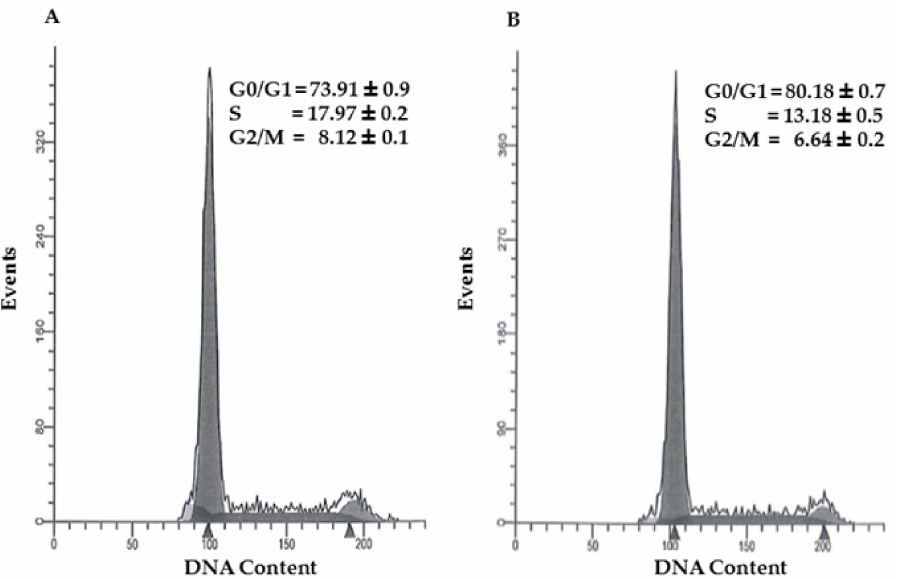
Figure 5. E ff ect of ( R ) - 1 on cell cycle. The cells were incubated for 48 h with the vehicle ( A ) or with 49 µ M of ( R )-1 ( B ), afterward the cell cycle distribution was determined by flow cytometry. The two panels report the cytofluorimeter outputs obtained in one typical experiment repeated twice with similar